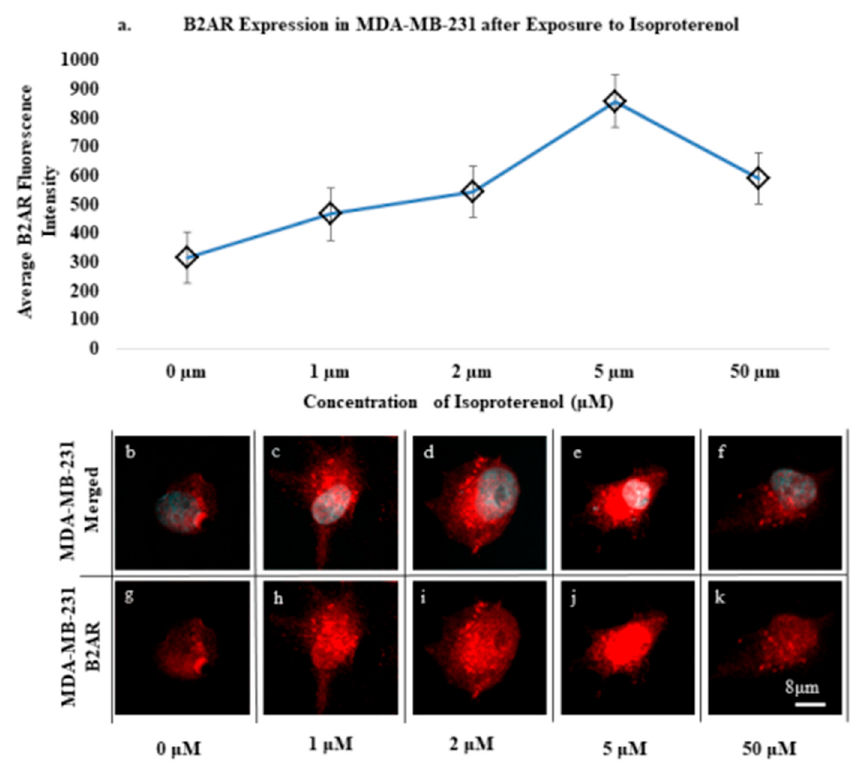
Figure 2. Average B2AR fluorescence intensity and endosome formation from increasing concentrations of isoproterenol: ( a ) Intensity of B2AR in the MDA-MB-231 cell line compared to increases in the concentration of isoproterenol. Bars = S.E. ( b – f ) Merged images of the MDA-MB-231 cells exposed to isoproterenol at 0, 1, 2, 5, and 50 μ M for 60 min. ( g – k ) B2AR images of the MDA-MB-231 cells exposed to isoproterenol at 0, 5, 10, 20, and 50 μ M for 60 min. More dotting is shown as endosome formation happens closer to the perinuclear space at increased concentrations of isoproterenol. (boxes = 45 µ m, scale bar = 8 μ m).